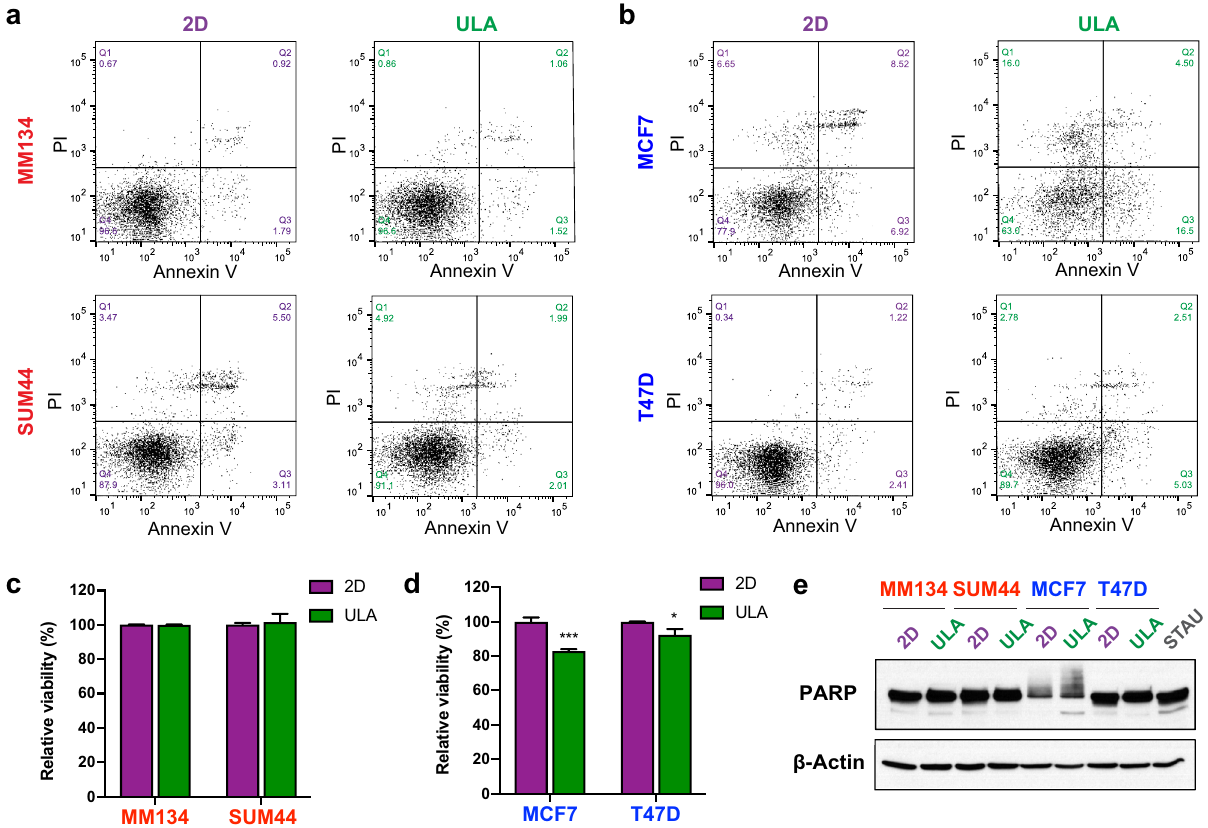
Figure 1. Anoikis resistance of human ILC and IDC cell lines. ( a , b ) Representative Annexin V and PI FACS staining plots of the ( a ) ILC (red) cell lines MM134 (top) and SUM44 (bottom) and ( b ) IDC (blue) cell lines MCF7 (top) and T47D (bottom) after 4 days in 2D (left; purple) or ULA (right; green) culture. ( c , d ) Quantification of the viable (Q4: Annexin V-/PI-) population in ( c ) ILC and ( d ) IDC cell lines. Data is displayed as mean percentage ± standard deviation relative to the 2D condition in each cell line. Graphs show representative data from two experiments (n = 3). p-values are from t tests. *p ≤ 0.05; ***p ≤ 0.001. ( e ) Immunoblotting for PARP in ILC and IDC cell lines after 2 days in 2D or ULA culture. STAU: positive control from T47D cells treated with 1 μM Staurosporine for 5 h. β-Actin was used as a loading